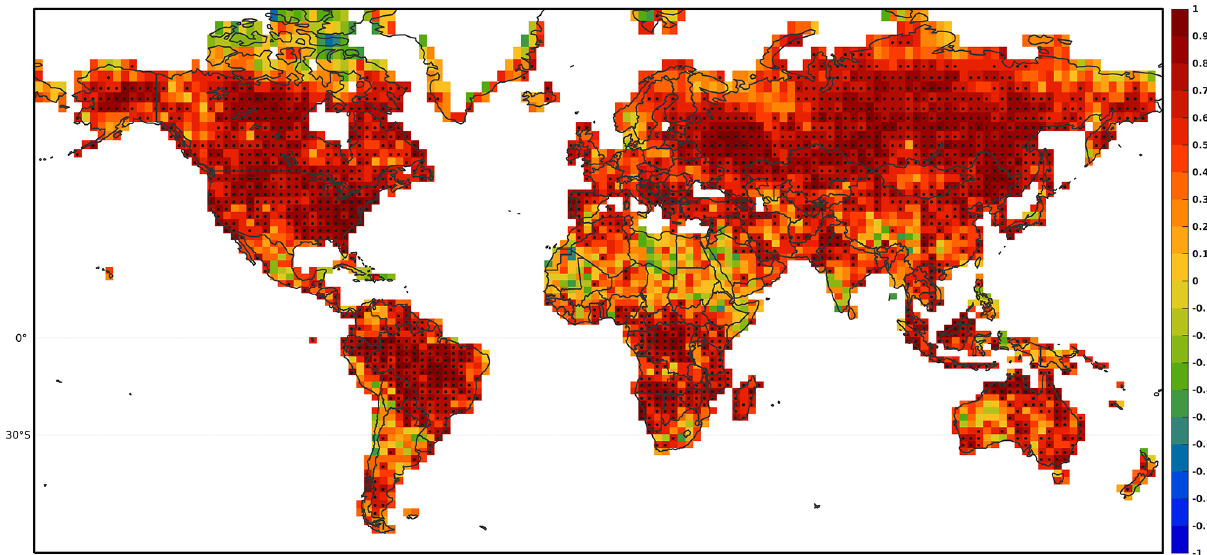
Figure 8. Pearson’s coefficient of correlation between the observed evolution of seasonally averaged HCHO columns during 2005–2016 and the model-calculated values (run A). The seasonal averages are calculated over the months of June–August in the Northern Hemisphere ( > 0 ◦ N), February–April in the 0–30 ◦ S latitudinal band, and December–February below the 30th parallel. The stippling represents the statistically significant correlation coefficient ( p <